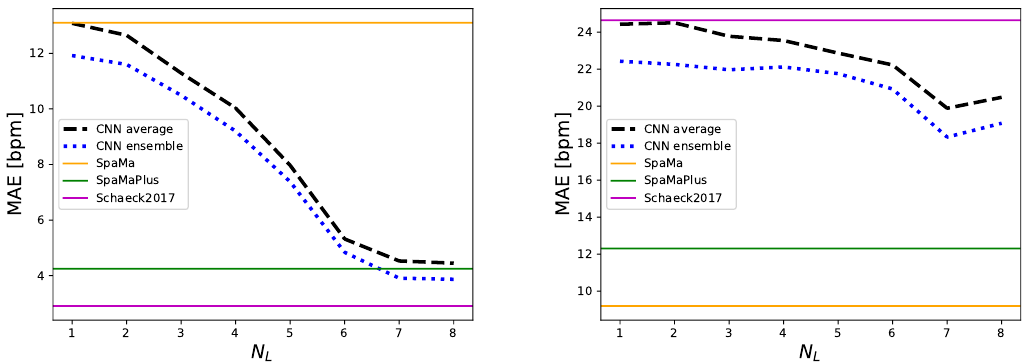
Figure 6. Evaluation results on IEEE_Training ( left ) and IEEE_Test ( right ) datasets, investigating the number of convolutional layers and ensemble prediction. LOSO results of the classical methods displayed for reference. N L refers to the hyperparameter defining the number of convolution-pooling layers, see Section